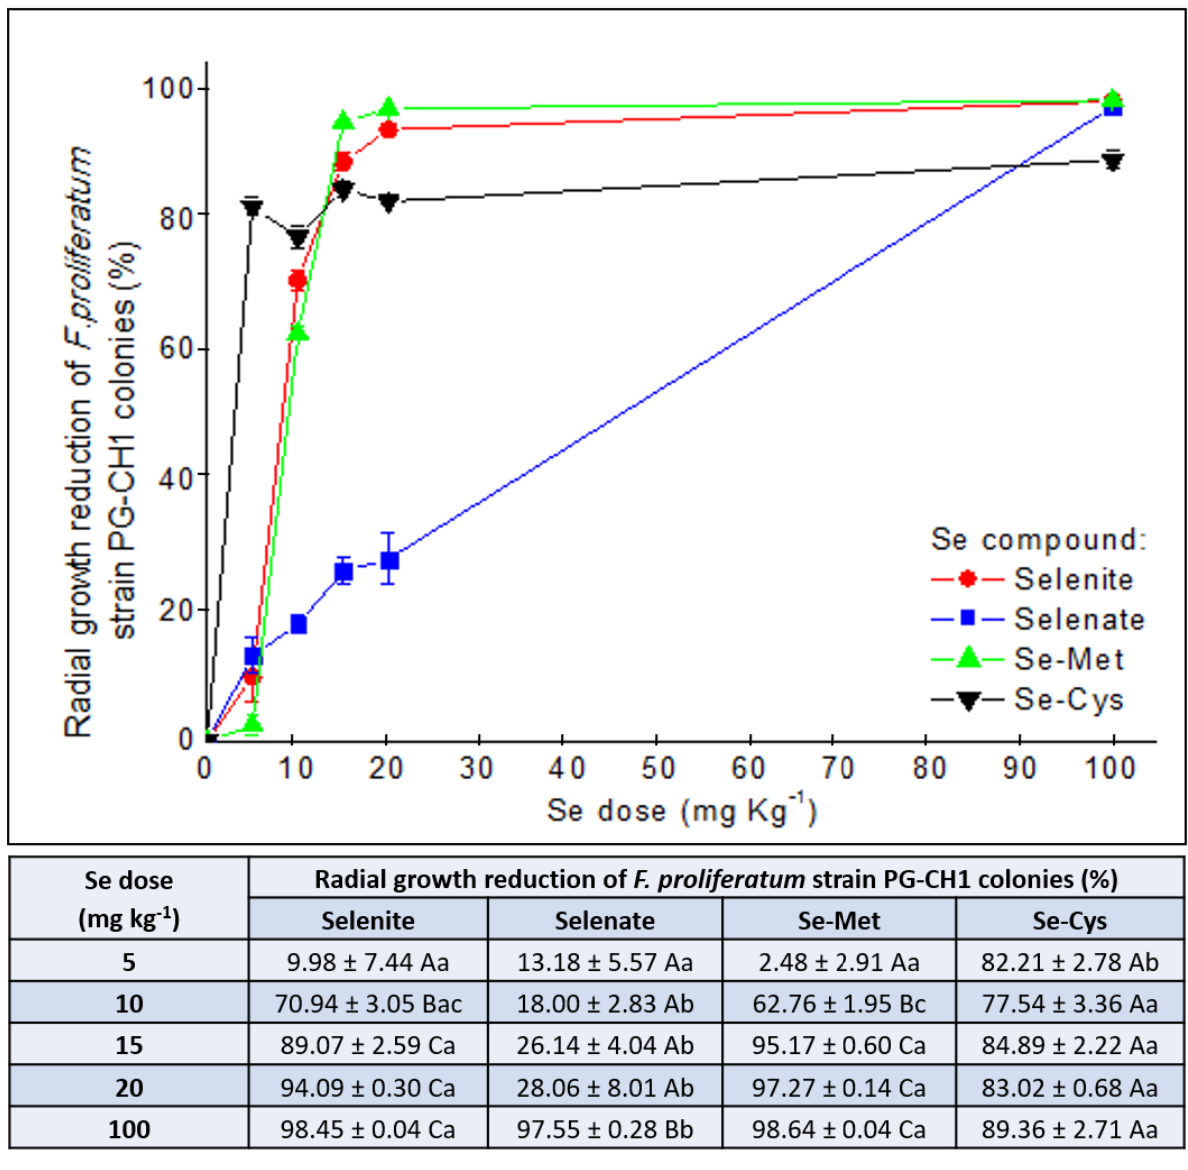
Figure 3. Effect of five selenium (Se) concentrations (5, 10, 15, 20, and 100 mg kg − 1 ) from sodium selenite (selenite; red circles), sodium selenate (selenate; blue squares), selenomethionine (Se–Met; green up–triangles), and selenocystine (Se-Cys; black down-triangles) on Fusarium proliferatum strain PG-CH1 colony development. The inhibitory activity was measured after 10 days of incubation at 22 ± 2 ◦ C in the dark and expressed as the mean ( ± standard error) of colony radial growth reduction (%) relative to the untreated control (0 mg kg − 1 of Se), calculated according to the equation: (radial growth control − radial growth treatment ): radial growth control × 100. One-way ANOVA was used to determine statistically significant differences in radial growth of the tested strain. In the table, within a Se form (A – C) or a Se concentration (a – b), means with the same letter are not significantly different at p < 0.05 based on the Tukey Honestly Significant Difference multiple comparison test.